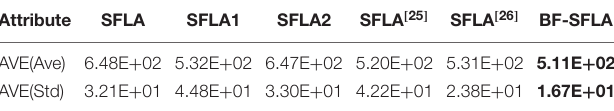
TABLE 6 | Addition and subtraction of discrete binary